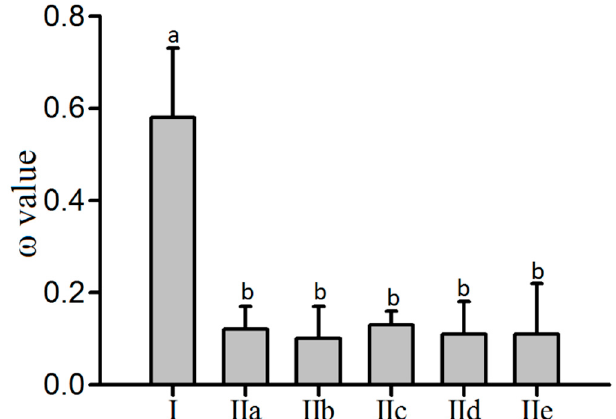
Figure 3. Mean ω values of P 3A -Type ATPase genes in different clades. Different lowercase letters represent significant differences among clades ( t -test, LSD test at p < 0.01). Error bars show the SE of means.